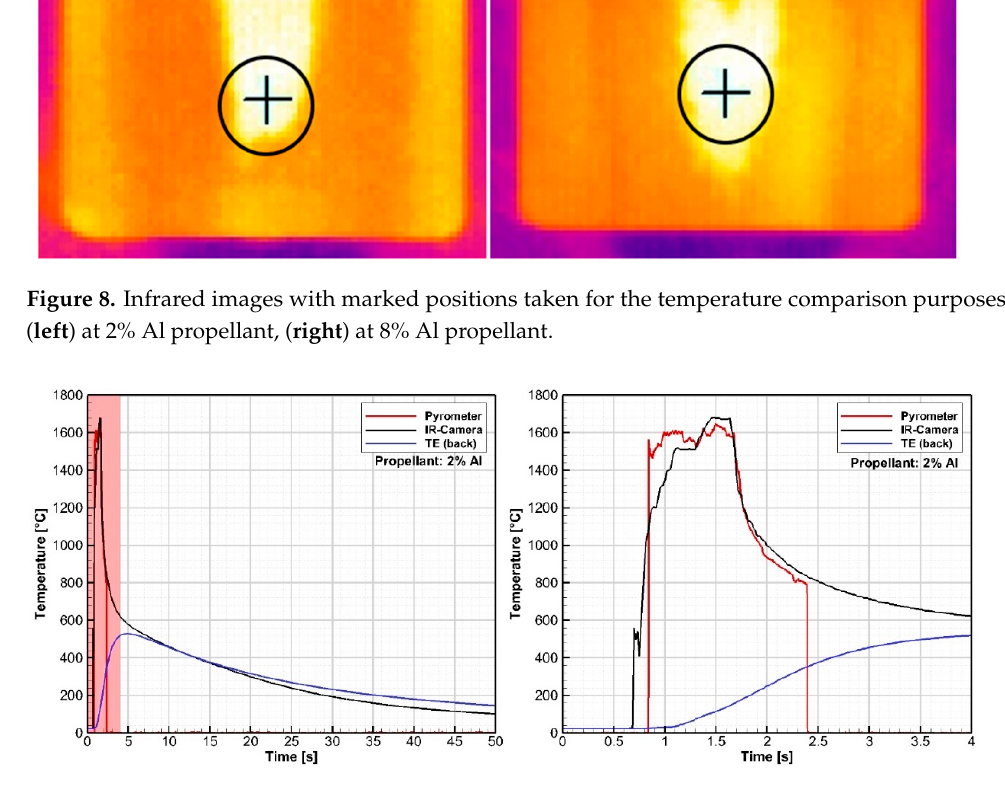
Figure 9. Temperature data from the 2% Al propellant test measured on front and back sides of the sample; ( left ) results from the duration of the experiment, ( right ) expanded view of red shaded region.